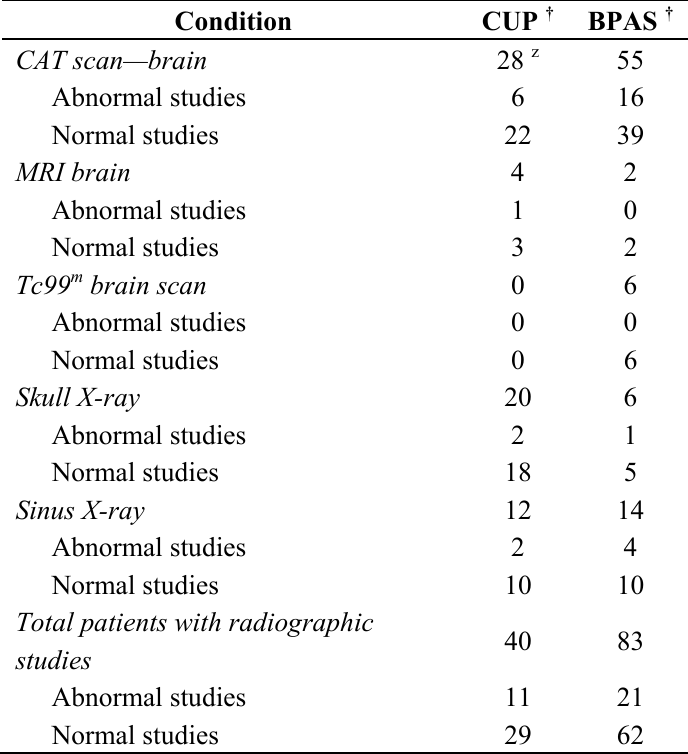
Table 9. Imaging studies in patients with